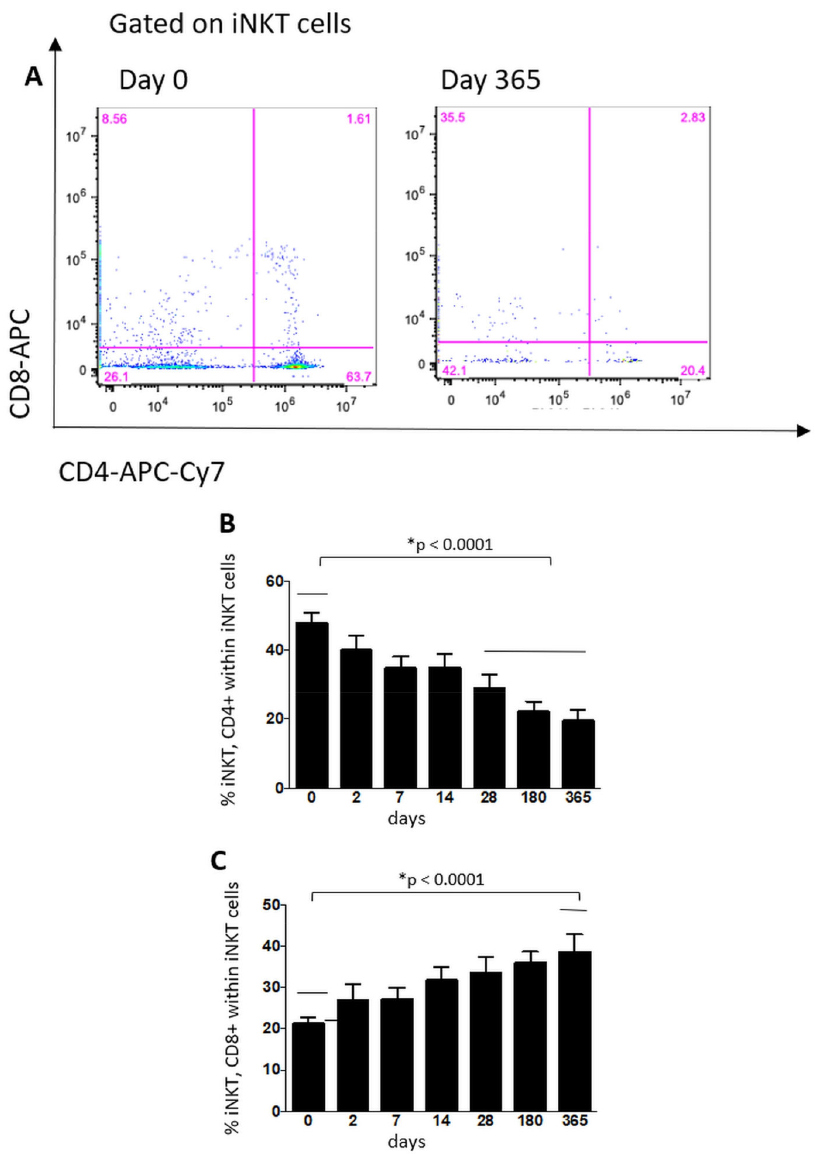
Figure 3. Representative dot plot showing the percentages of CD4+, CD8+ and DN iNKT cells of the same patients before and after 1 year of therapy (panel A ). Percentage among iNKTcells of iNKT CD4+ cells (panel B ) and iNKT CD8+ cells (panel C ) derived from MS patients before starting fingolimod (0) and at different time-points throughout one year. Data are represented as mean ± standard error of the mean. N = 36 patients throughout days 0–28, N = 28 at 180 days and N = 20 at 365 days. Comparison between Patients with and without Infections The mean percentage of CD8+ T cells at all time-points was lower (46.5% ± 16 versus 33.5% ± 13.8; p = 0.0001, significant after the Bonferroni correction) in case of an infection during treatment and, in particular, in case of a VZV infection (23.3% ± 7) (Figure 4). Patients with mean percentages of CD8+ T cells < 35% had four-fold odds of an infection (odds ratio: 4.4; 95% confidence interval: 2–10; p < 0.0001). The baseline CD8+ T cell percentages were, likewise, lower in patients with a subsequent infection (26.4 ± 6.5 versus 33 ± 8.7; p = 0.048, not significant after the Bonferroni correction). The remaining analyzed cell subsets did not differ significantly between the two